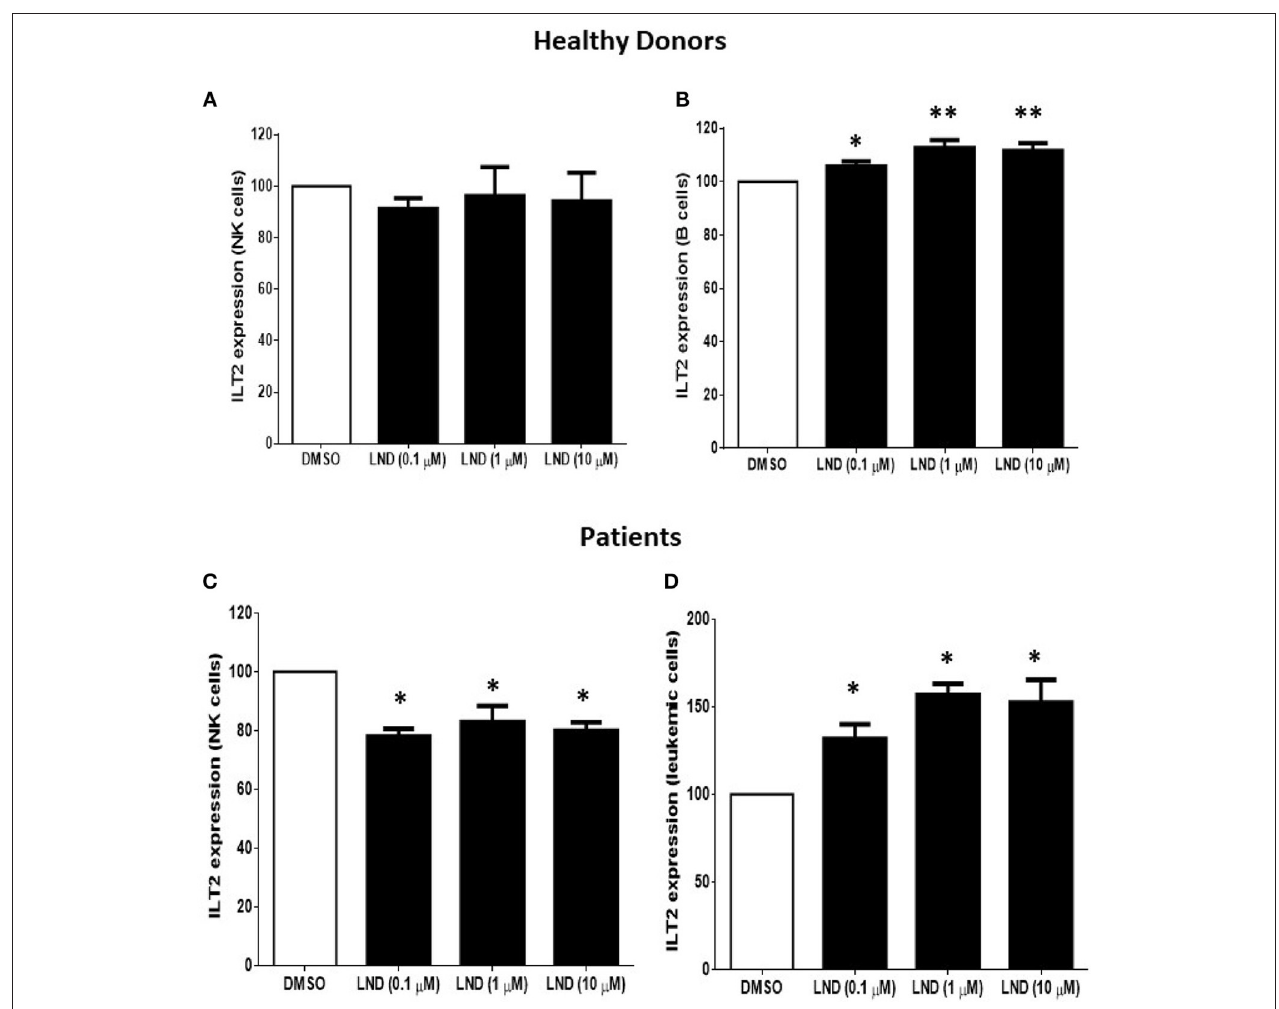
FIGURE 3 | Effect of lenalidomide on ILT2 expression on NK cells and B cells from healthy donors and patients with CLL. The expression of ILT2 on NK cells and B cells from healthy donors (A,B) and patients with CLL (C,D) was evaluated by flow cytometry in PBMCs obtained from 4 CLL patients and 6 controls after the treatment with different doses of lenalidomide (LND) (0.1, 1, and 10 µ M) for 7 days. The figure shows the comparison of the MFI of ILT2 expression normalized to the DMSO condition ± SEM. SEM, Standard Error of the Mean; Wilcoxon Matched-Pairs Signed Ranks test; * P < 0.05, ** P <